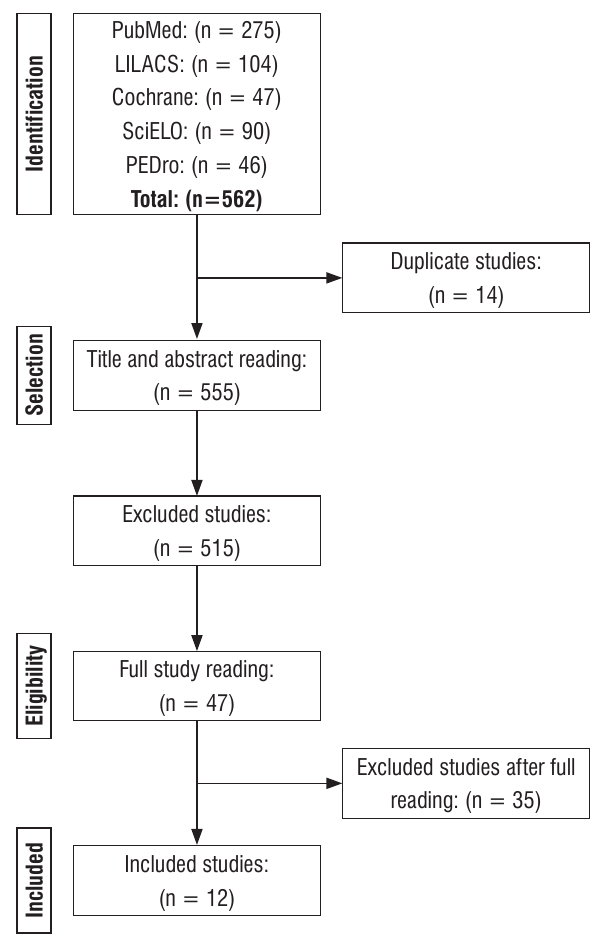
FIGURE 1 - Study search and selection